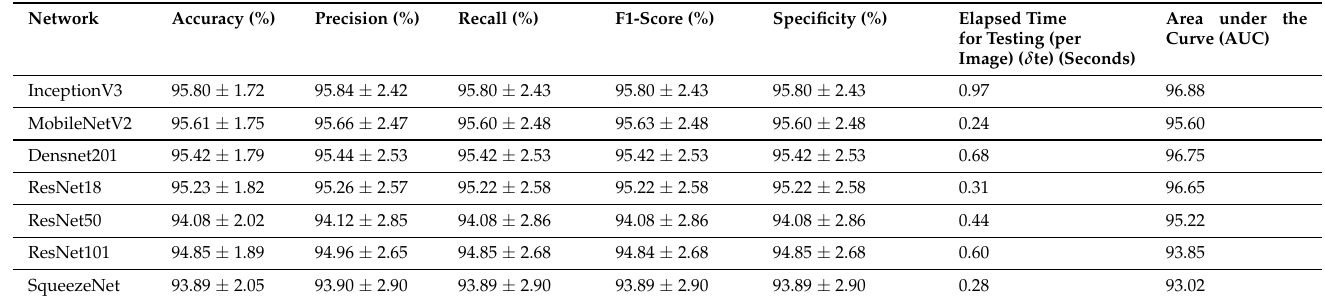
Table 3. Comparison of the performance of different CNN models in thalassaemia